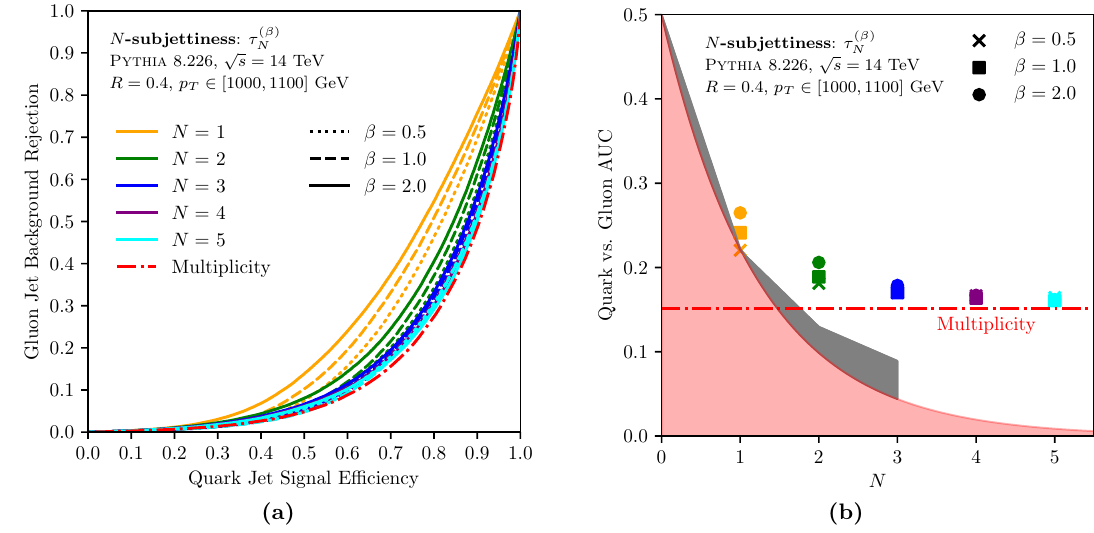
Figure 8. The (a) ROC curves and (b) AUCs for N -subjettiness observables for N up to 5 and (cid:12) 0 : 5 ; 1 : 0 ; 2 : 0 . The AUCs indeed satisfy the predicted general N -emission bound 1 2 f g (red) and speci(cid:12)c calculated N -subjettiness bounds for N eq. (3.4) to the results of eq. (7.9) (gray), with minimal (cid:12) dependence. The performance of consti- tutent multiplicity is also shown, with N -subjettiness approaching the classi(cid:12)cation performance of multiplicity for large N .